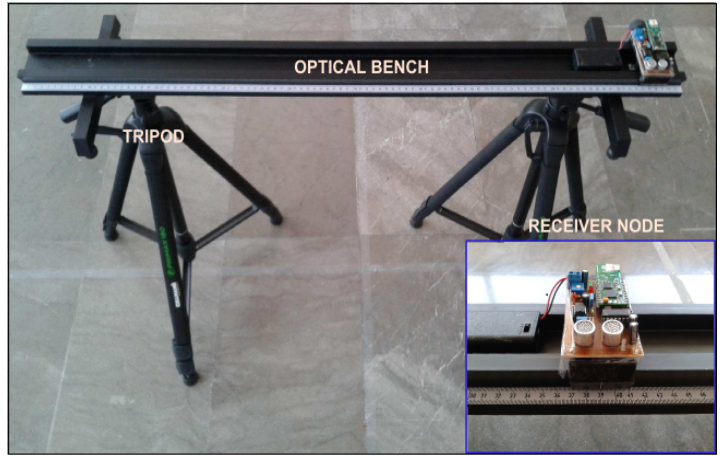
Figure 11. Test bench used to position the receiver node in different positions.